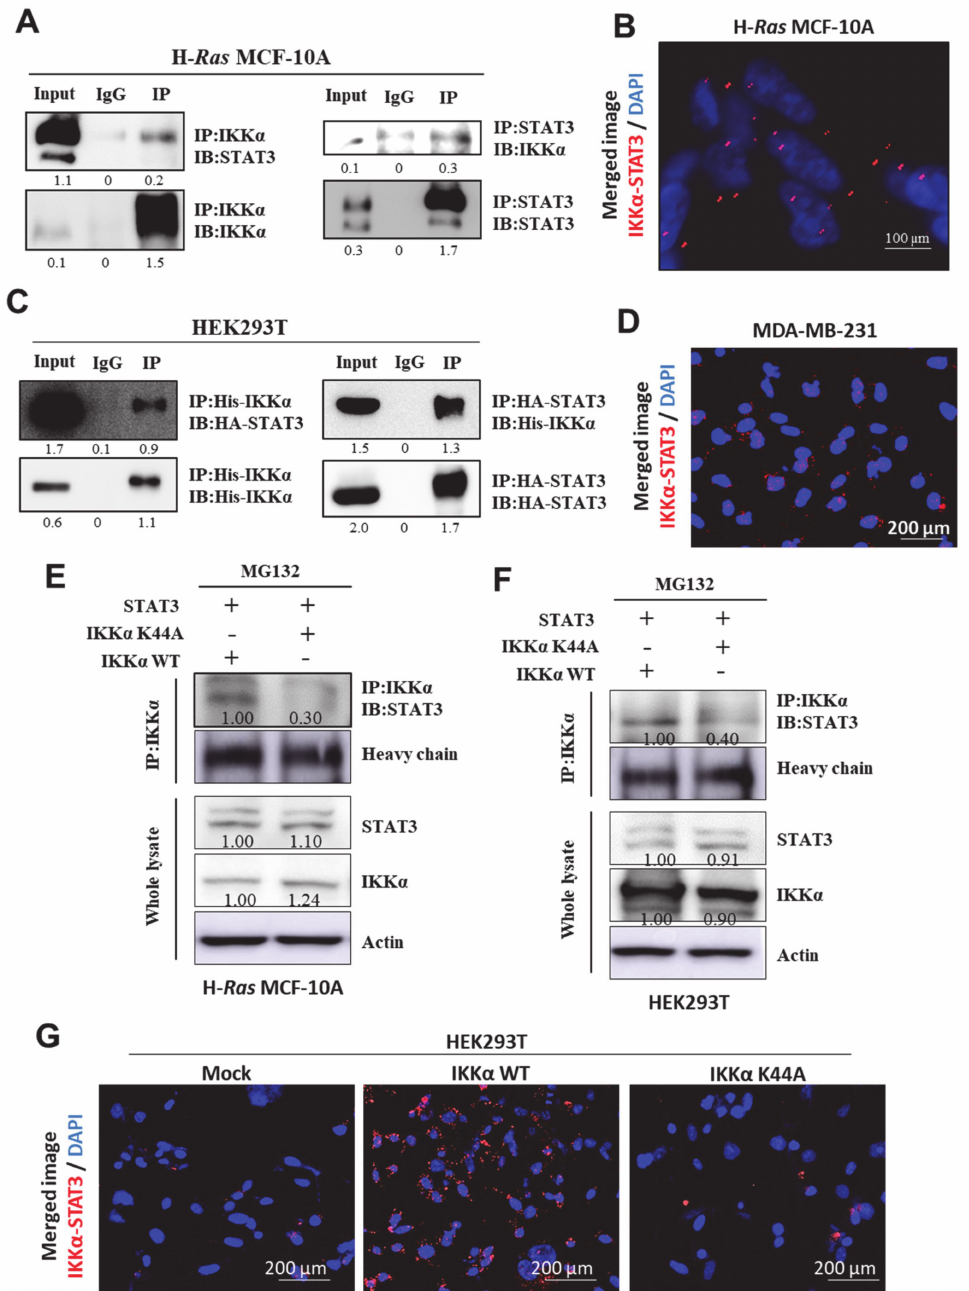
Figure 5. STAT3 directly interacts with IKK α in vitro. ( A , C ) IP analysis showing a physical interaction between IKK α and STAT3 in H- Ras MCF-10A ( A ) and HEK293T ( C ) cells. Immunoprecipitation was performed with IKK α (left) or STAT3 (right) antibodies, followed by immunoblotting with antibodies for STAT3 and IKK α , respectively. IgG, a negative control for immunoprecipitation; input, total protein lysate. ( B , D ) Duolink analysis showing the interaction between STAT3 and IKK α in H- Ras MCF-10A ( B ) and MDA-MB-231 ( D ) cells. The representative image was visualized under the fluorescent microscope. ( E , F ) H- Ras MCF-10A ( E ) and HEK293T ( F ) cells were transfected with IKK α wild type (WT) or K44A mutant (K44A) in the presence of STAT3 construct for 48 h, followed by MG132 treatment for additional 2 h. Immunoprecipitation analysis showing the interaction between STAT3 and either WT or K44A IKK α . ( G ) Duolink analysis showing the STAT3 binding to IKK α WT or K44A mutant in HEK293T